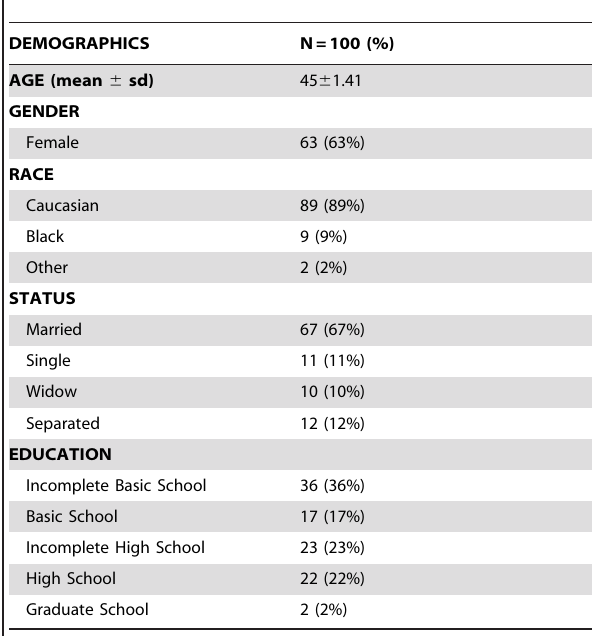
Table 1. Baseline participant